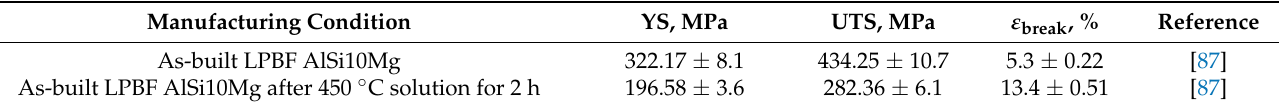
Table 4. Mechanical properties of the LPBF-built and cast AlSi10Mg after solution and T6 aging heat treatment compared with wrought counterparts and AA-6061